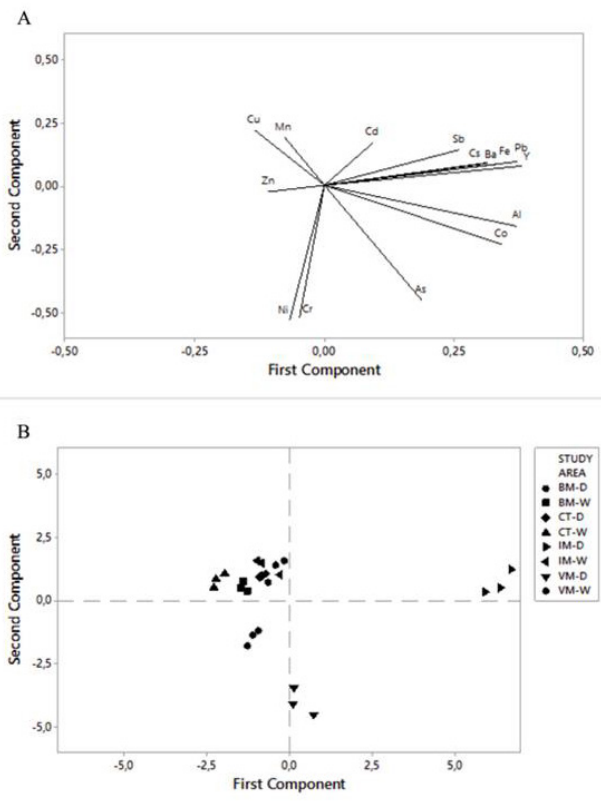
Fig 4 . Loading Plot (A) and Score Plot (B) - Principal components 1 and 2 - obtained from mean composition of mineral elements in 60 SPM samples from four areas in the Iron Quadrangle in dry (D) and wet (W)